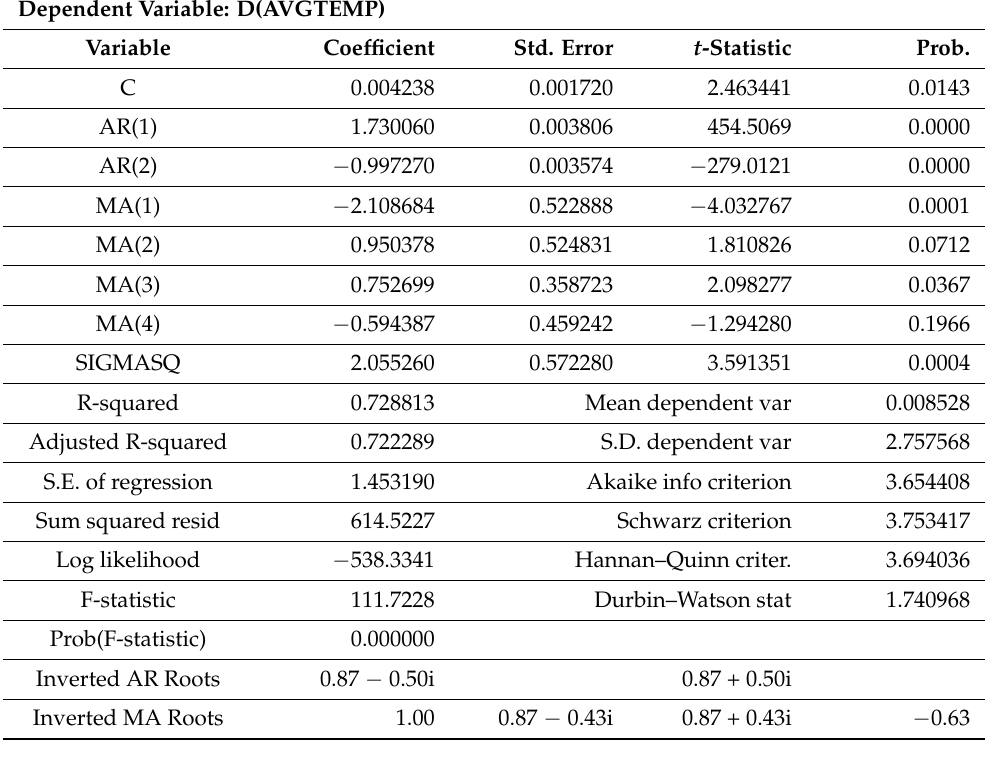
Table 4. The estimated parameter of ARIMA (2, 1, 4) as the best fitted model.